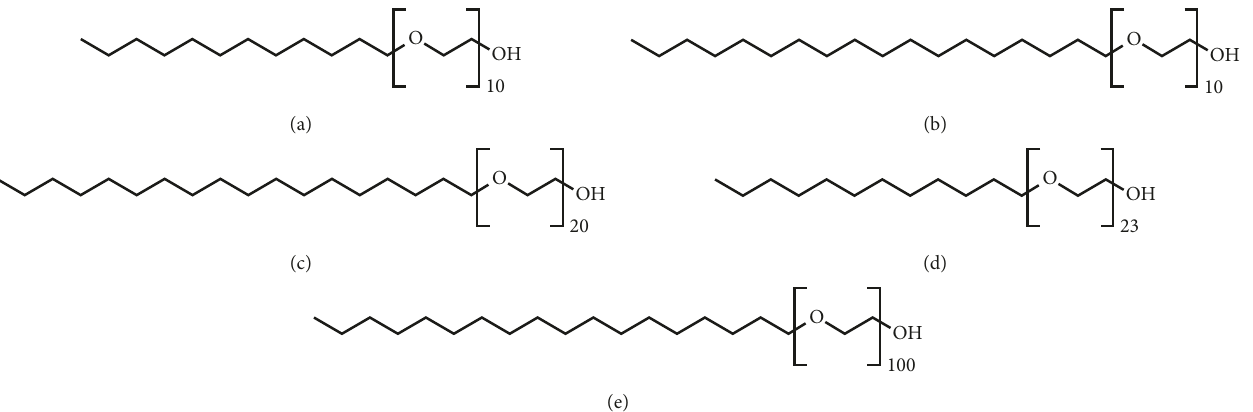
Figure 1: Molecular structures of polyoxyethylene alkyl ether-type emulsifiers used in this work. (a) polyoxyethylene 10 lauryl ether (P10L); (b) polyoxyethylene 10 stearyl ether (P10S); (c) polyoxyethylene 20 stearyl ether (P20S); (d) polyoxyethylene 23 lauryl ether (P23L); (e) polyoxyethylene 100 stearyl ether